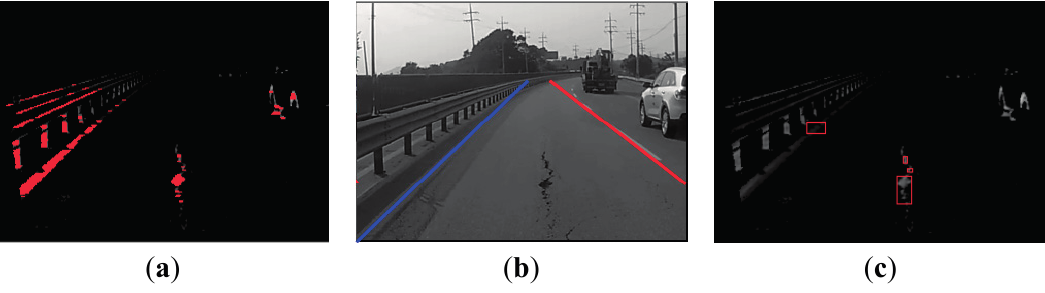
Figure 4. Candidate extraction: ( a ) line segmentation; ( b ) lane detection; ( c ) line grouping.